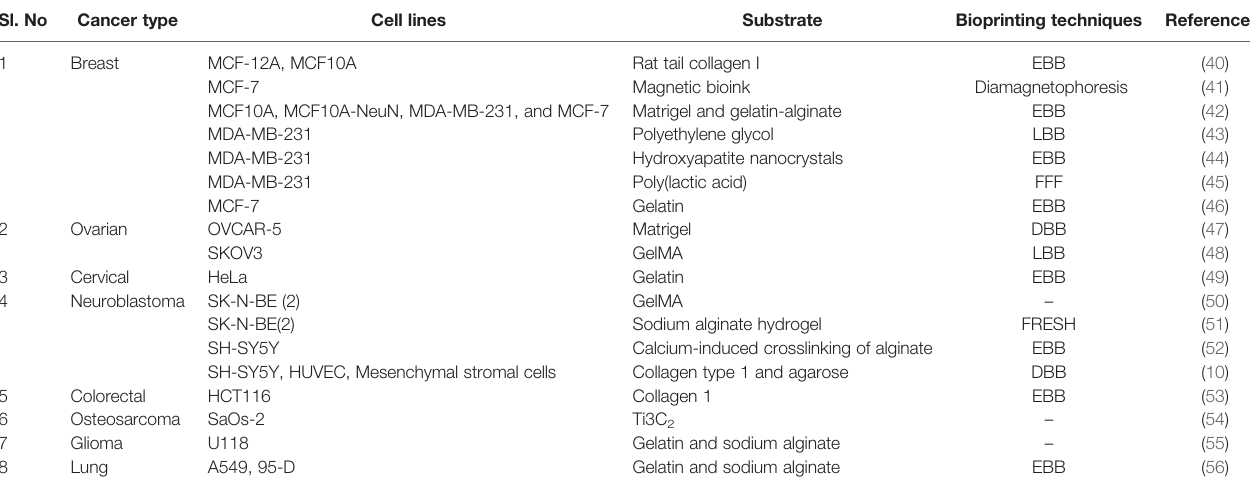
TABLE 2 | Bioprinting substrates and techniques employed for each cancer type. Sl.